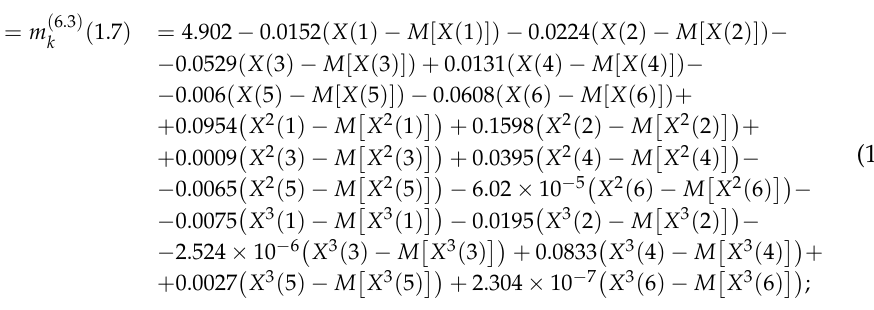
Table 8. Coordinate functions β